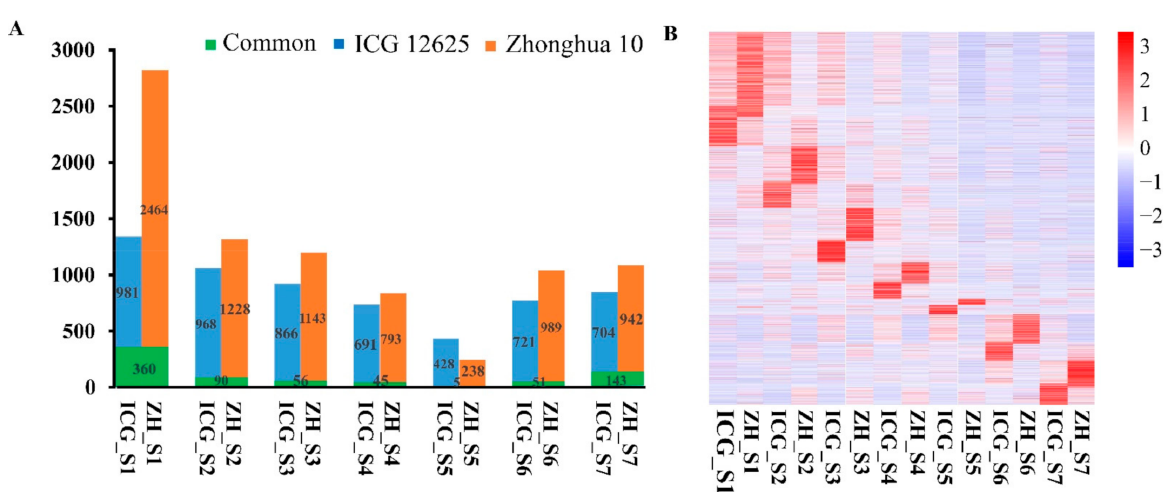
Figure 3. Stage-specific expressed genes during seed development in ICG 12625 and Zhoanghua 10. ( A ) The number of stage-specific expressed genes specifically and commonly in ICG 12625 and Zhonghua 10 at each stage of seed development. ( B ) Heatmap showing the expression profile of stage-specific expressed genes in ICG 12625 and Zhonghua 10 during seed development. Color scale represented the